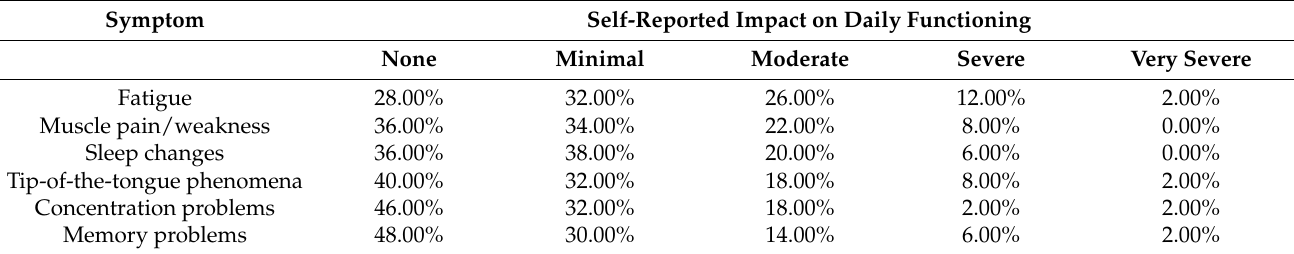
Table 2. Frequency distribution of symptoms persisting after hospital